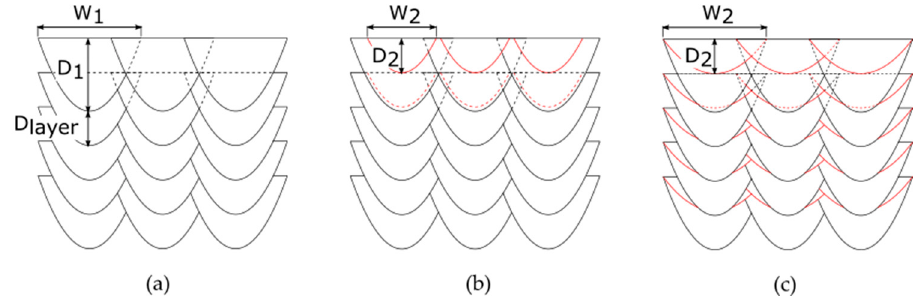
Figure 6. Expected structure with resulting width and depth of the melt pools related to laser 1 (W 1 and D 1 ) and to laser 2 (W 2 and D 2 ) for ( a ) single-laser, ( b ) dual-laser with P laser2 of 125 W and d laser2 of around 85 µm and ( c ) dual-laser with P laser2 of 200 W and d laser2 of around 170 µm.